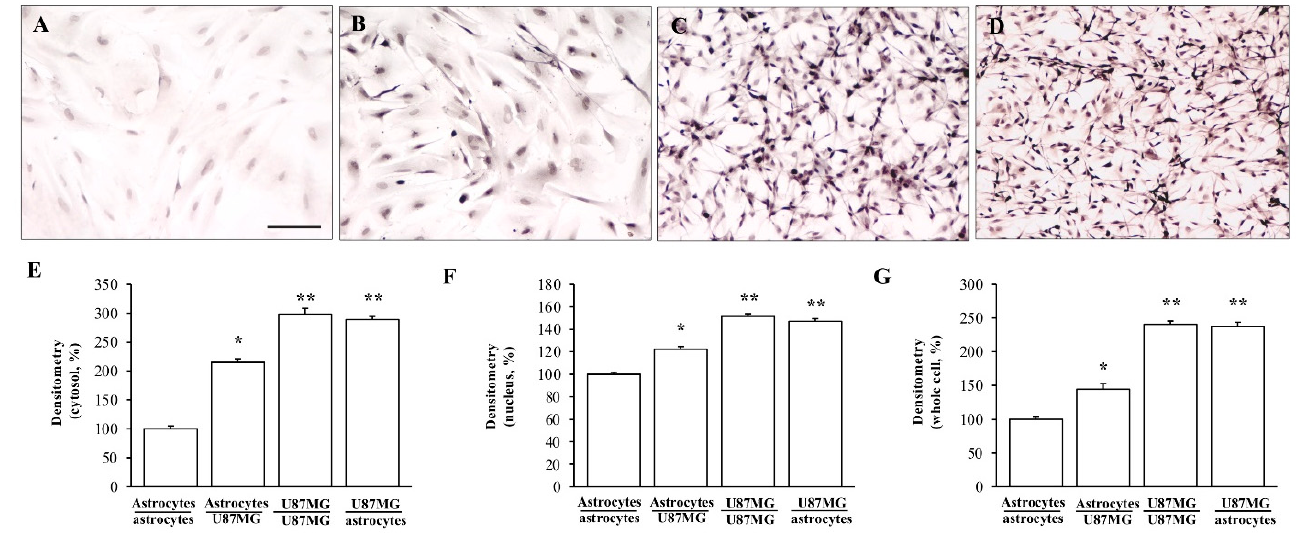
Figure 3. α -Syn immuno-cytochemistry in co-cultures of astrocytes and GBM cells. Representative pictures of α -syn immuno-cytochemistry within astrocytes co-cultured with astrocytes ( A ), astrocytes co-cultured with GBM cells ( B ), GBM cells co-cultured with GBM cells ( C ), and GBM cells co-cultured with astrocytes ( D ). Graphs report densitometry of α -syn staining within the cytosol ( E ), nucleus ( F ), and whole cell ( G ). Measurements refer to the cells, which are named at first in the co-culture. Data are given as the mean percentage ± S.E.M. of optical density for each experimental group (assuming astrocytes co-cultured with astrocytes as 100%) obtained from N = 30 cells per group. * p < 0.05 compared with astrocytes co-cultured with astrocytes. ** p < 0.05 compared with astrocytes co-cultured with GBM cells. Scale bar = 35.4 μ m.